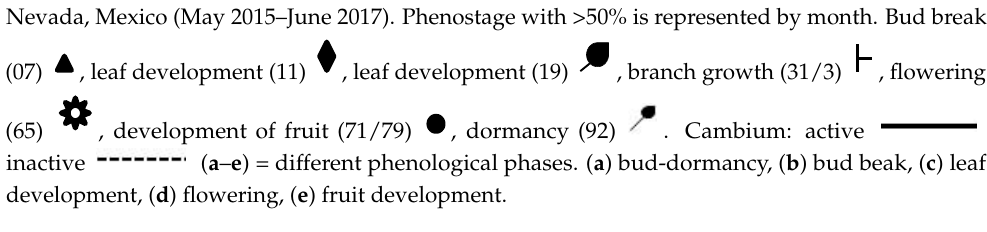
Figure 4. Cambial activity in the three species over the altitudinal gradient summarized for one year, May 2015 to May 2016. ( A ) Alchemilla procumbens , ( B ) Acaena elongata , ( C ) Ribes ciliatum . Sym- bols represent active cambium at each altitude. ( a , c , e ) = active cambium plus xylogenesis (vertical red line); ( b , d , f ) = inactive cambium (vertical red line). Scale bar is 20 μ m.